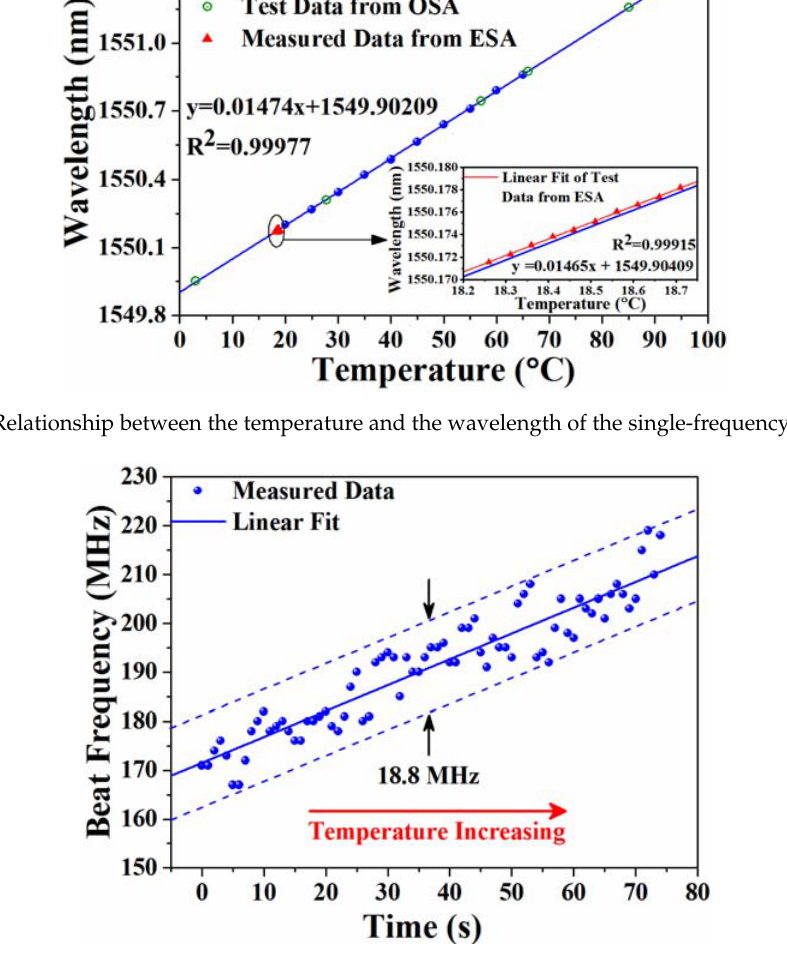
Table 1. Performance comparisons of the proposed sensor with sensors referred to prior.